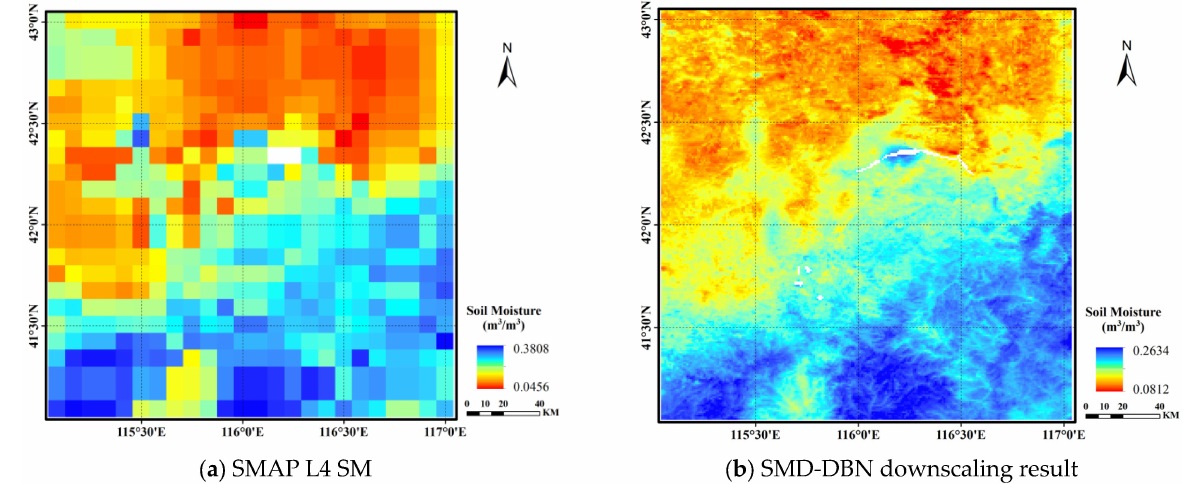
Figure 5. Comparison of downscaling result and original SM data.